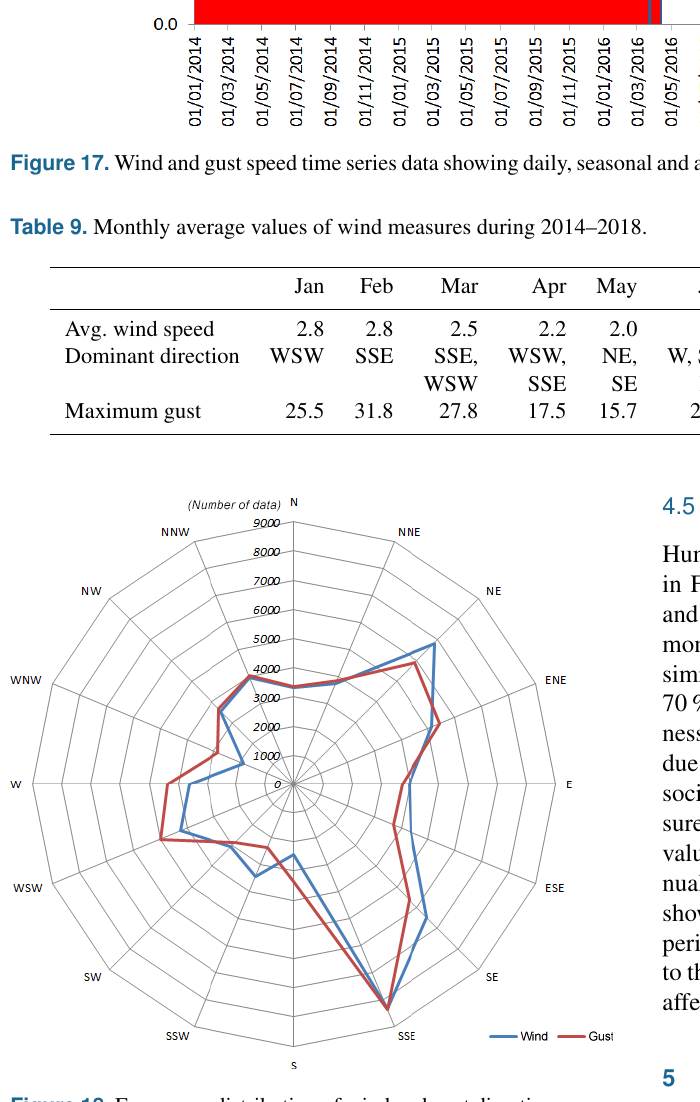
Figure 18. Frequency distribution of wind and gust directions mea- sured during